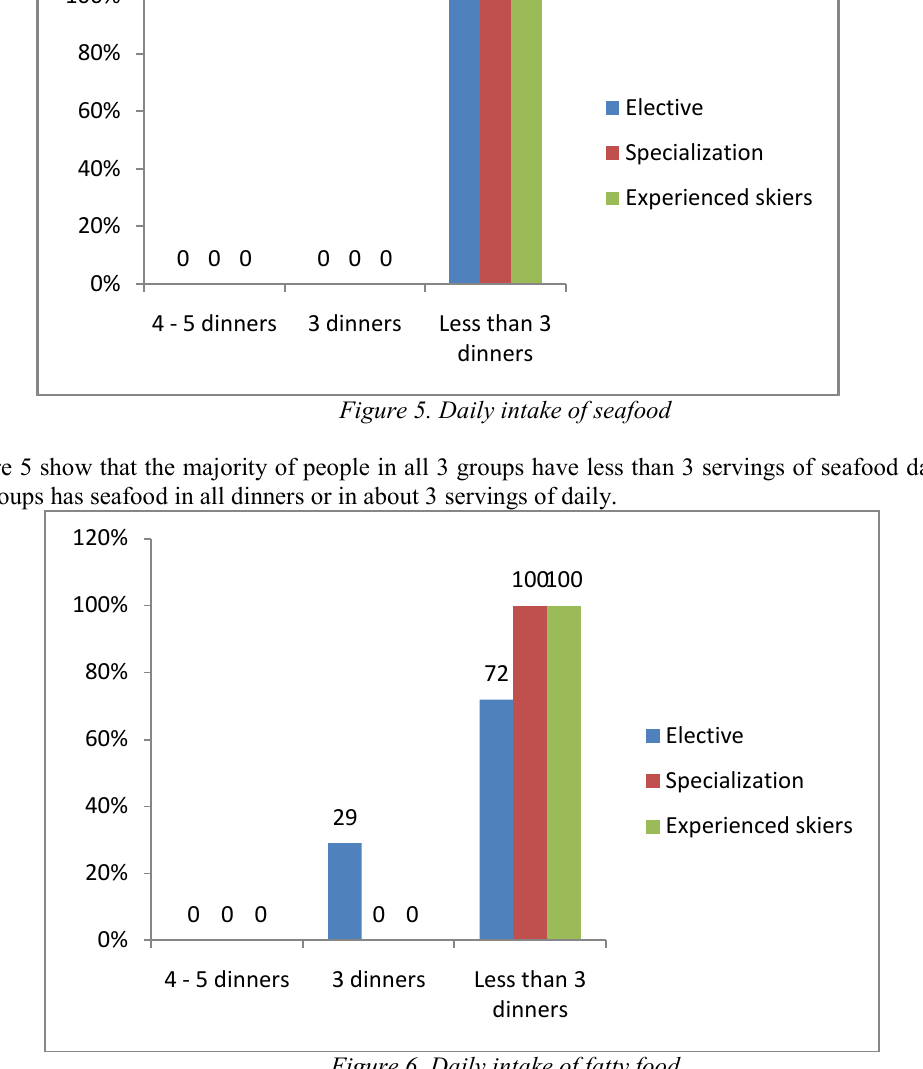
Figure 6. Daily intake of fatty